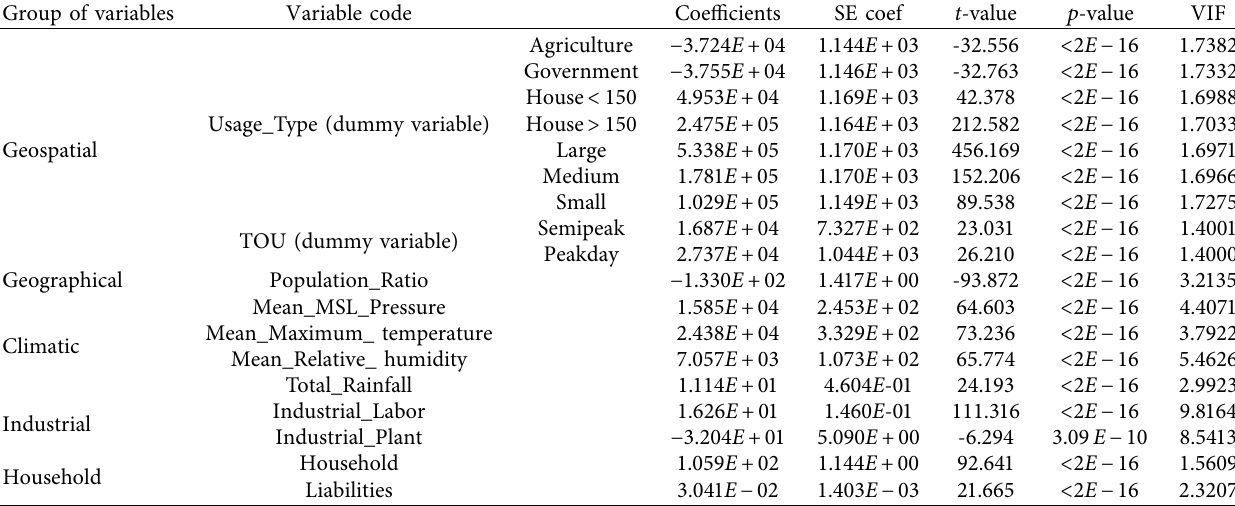
Table 4: Feature importance based on the SWR model.